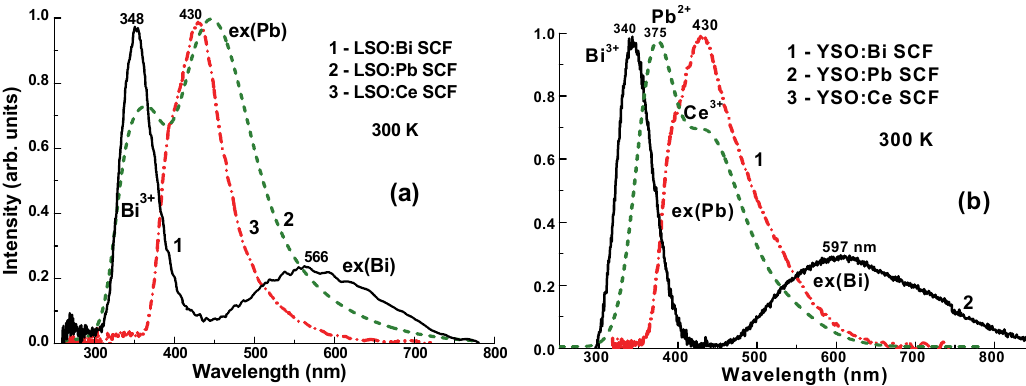
Figure 2. Normalized cathodoluminescence (CL) spectra of nominally undoped (1, 2) and Ce 3+ -doped (3) ( a ) LSO SCFs and ( b ) YSO SCFs at 300 K.